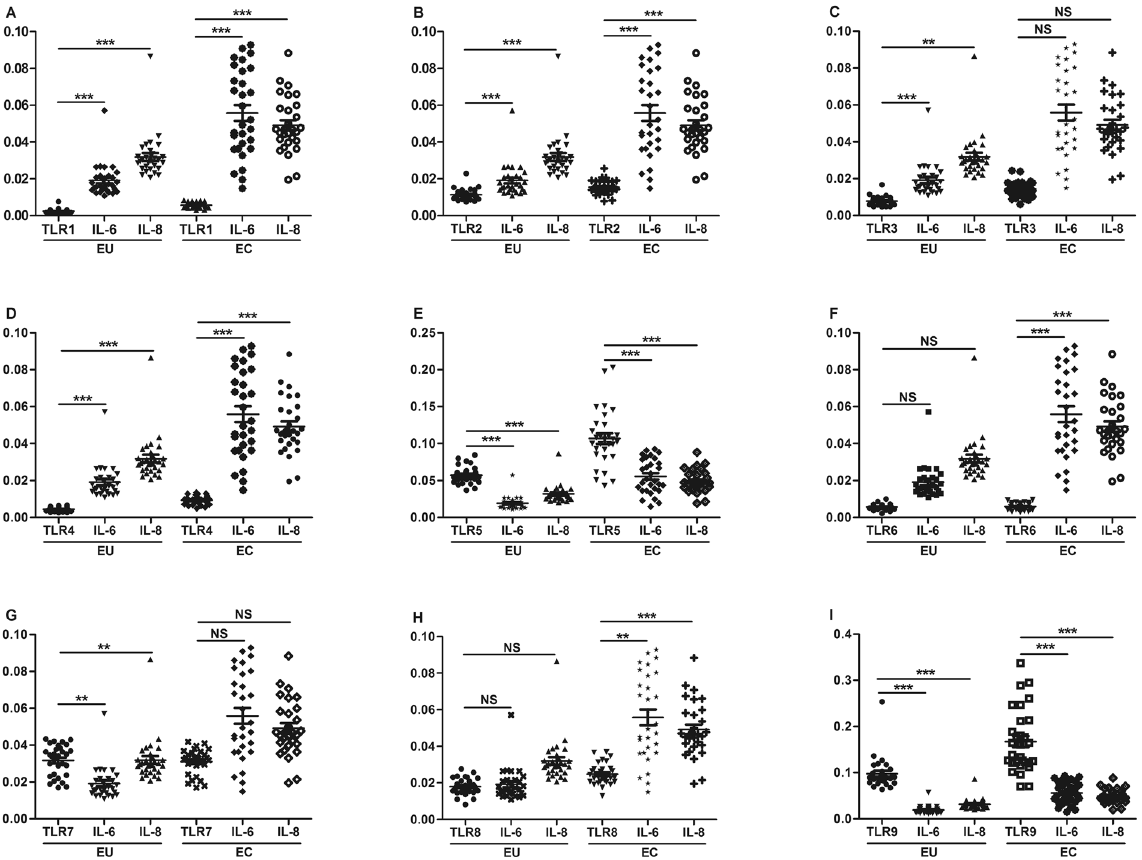
Figure 3. Correlations between the mRNAs expression of IL-6, IL-8 and TLRs in adenomyosis. CE: endometrium without adenomyosis; EU: eutopic endometrium with adenomyosis; EC: ectopic endometrium with adenomyosis. NS P > 0.05; * P < 0.05; ** P < 0.01; *** P <